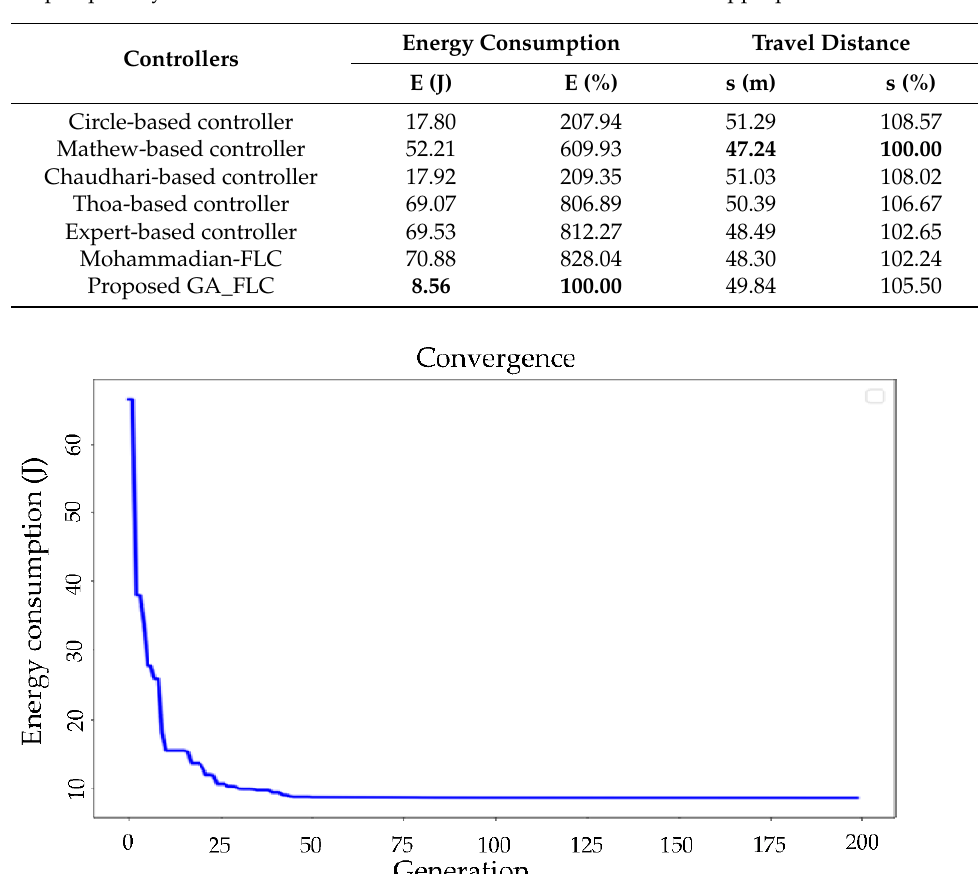
Table 11. Energy consumption and travel distance of the robot when the robot tracks the zigzag path by the different controllers. Bold values are the best in the appropriate column.